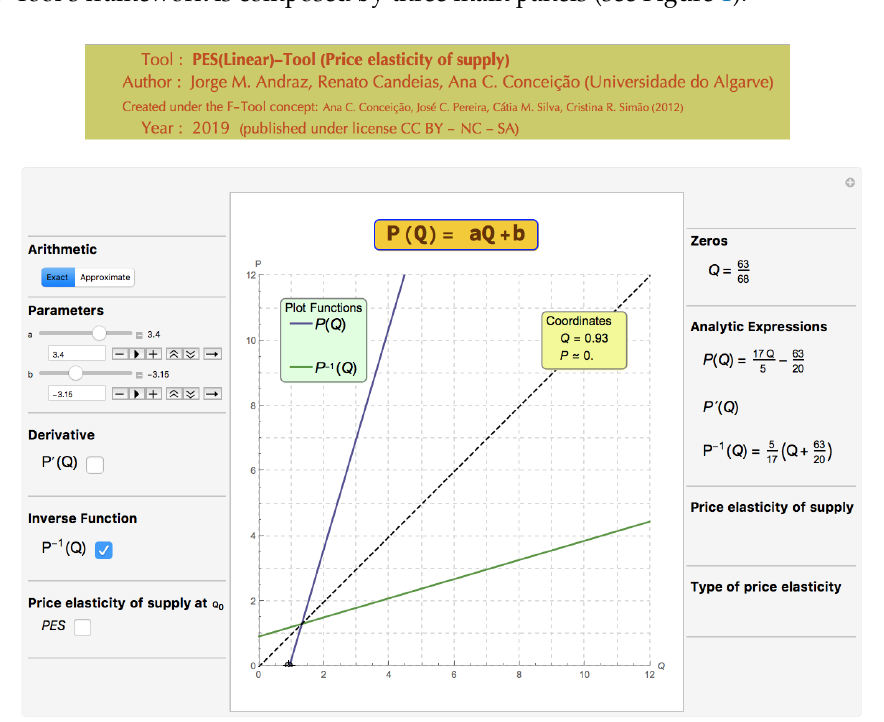
Figure 1. A general example of the price elasticity of supply (PES)(Linear)-Tool: How to get the market supply function in terms of the variable Q